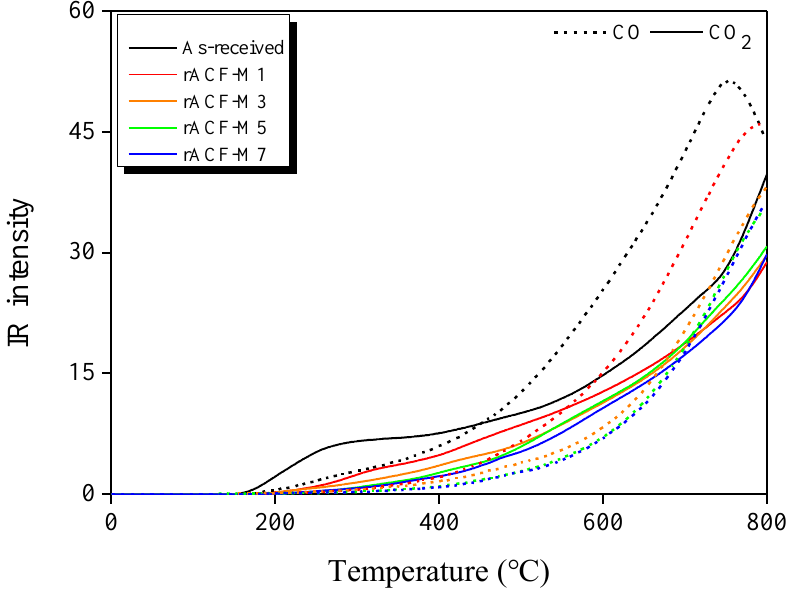
Figure 2. Intensity curves of carbon monoxide and carbon dioxide during the pyrolysis of activated carbon obtained through the thermogravimetric analysis–infrared gas